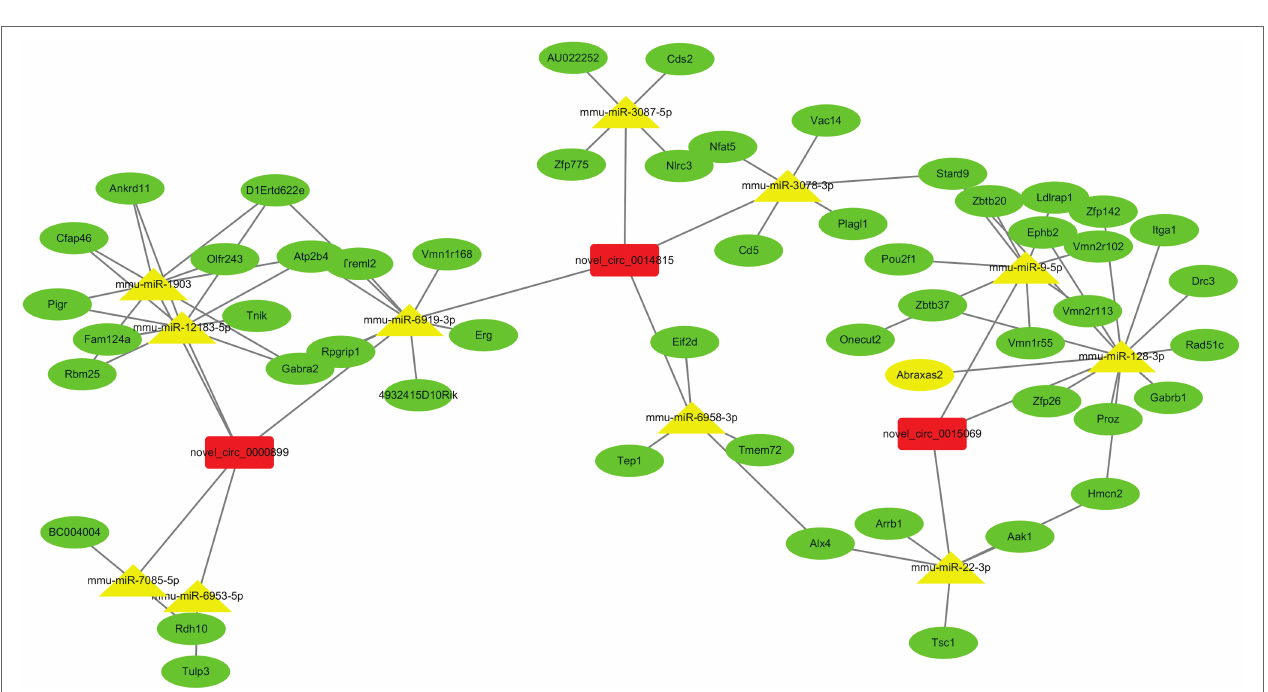
FIGURE 5 | Validation of the top 10 differentially expressed circRNAs using qRT-PCR. Changes in differentially expressed circRNA were confirmed using qRT-PCR in the sham and VILI 6 h groups, n = 5. Bars represent means ± standard deviation. * p < 0.05 VILI 6 h vs. sham.